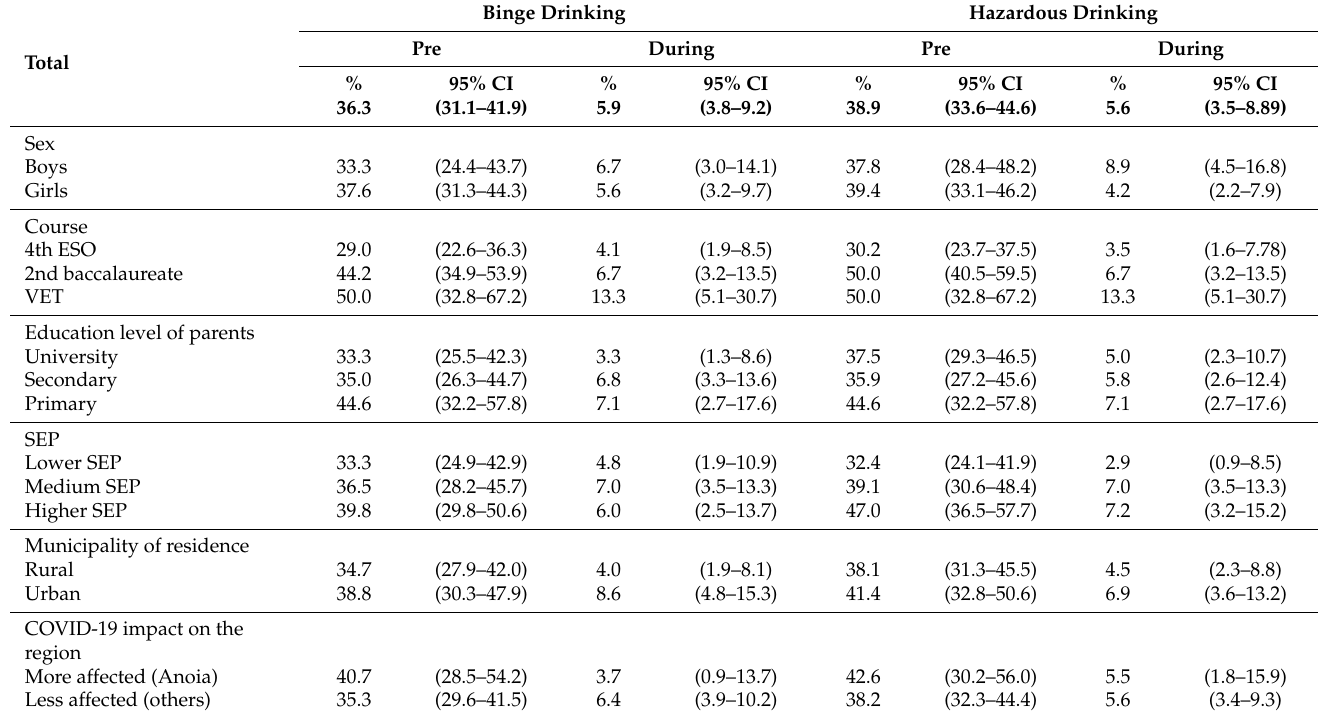
Table 2. Prevalence of binge drinking and hazardous consumption of alcohol, before and during lockdown due to the COVID-19 pandemic in the 303 adolescents from Central Catalonia who participated in wave 1 and wave 2 of DESK-COVID- Cohort project.